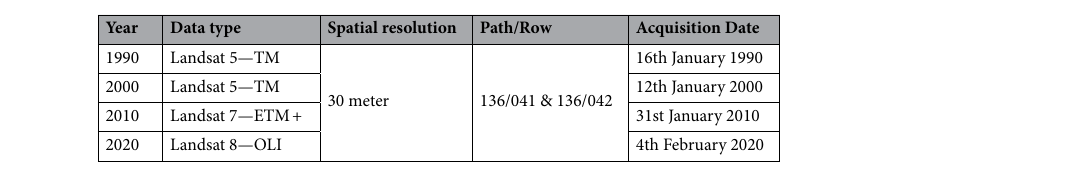
Table 1. Details of landsat images used in the